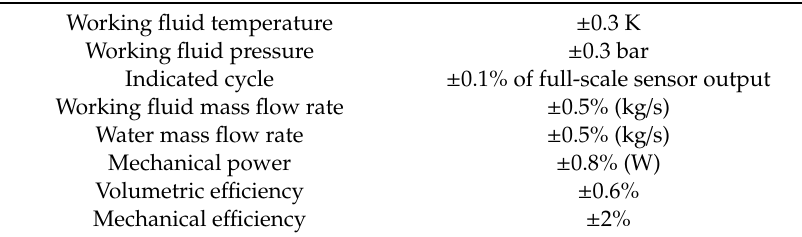
Table 2. Measurement